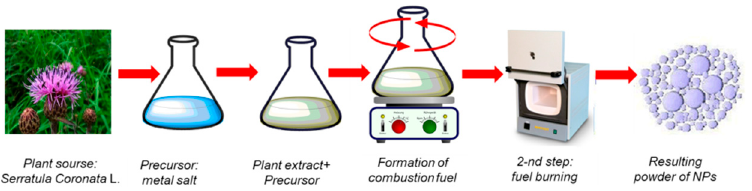
Figure 1. Schematic representation of obtaining biogenic ZnO nanoparticles via wet combustion